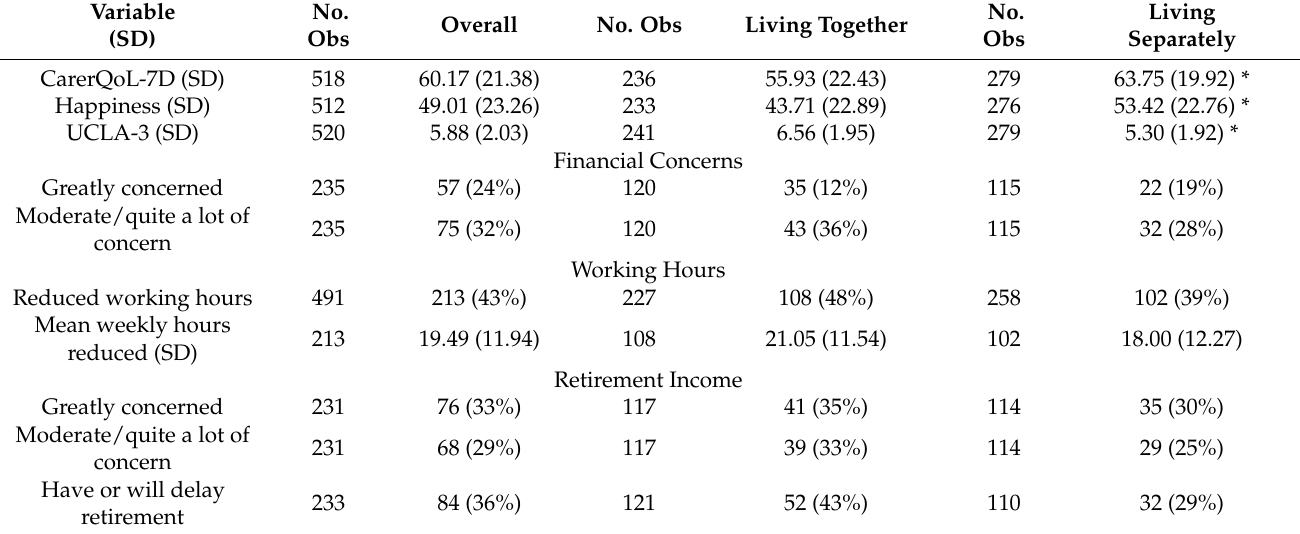
Table 3. Impacts and value of caring.